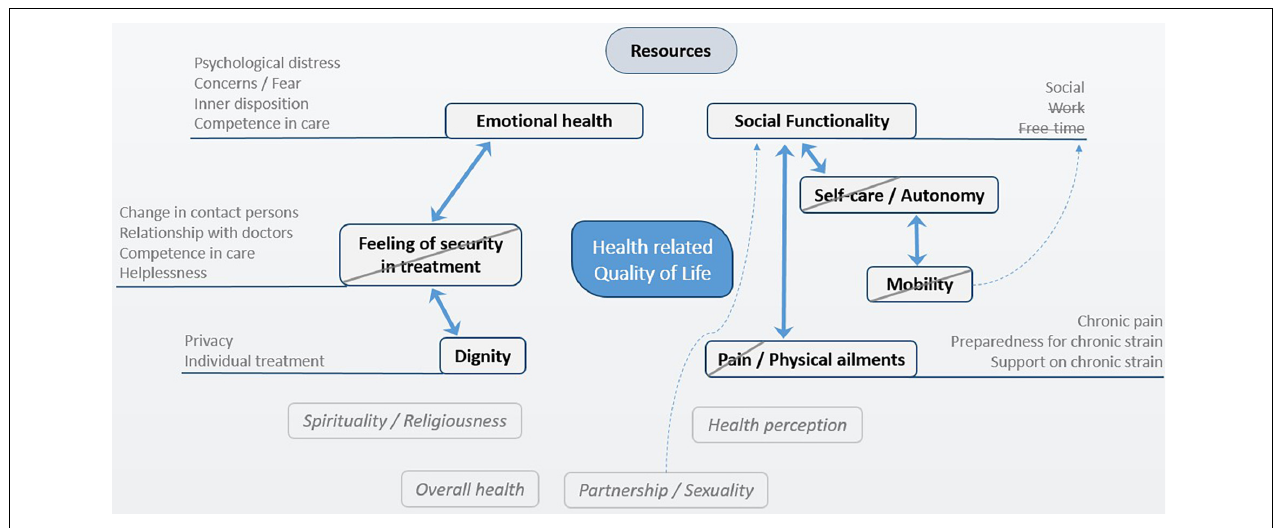
FIGURE 2 | System of dimensions of HrQoL in cancer